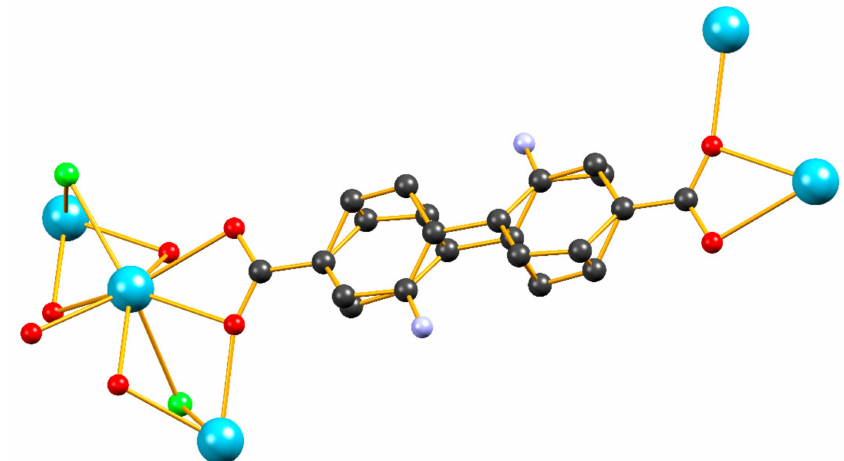
Figure 3. Partial view of the crystal structure of 9 highlighting the disorder of the biphenyl bridging unit. The nitrogen atoms were refined with a site occupancy of ca. 17%. Hydrogen atoms and the coordinated DMF molecules are omitted for clarity. Color code: Lanthanum: turqoise, Carbon: black, Oxygen: red, Nitrogen: blue, Chlorine: